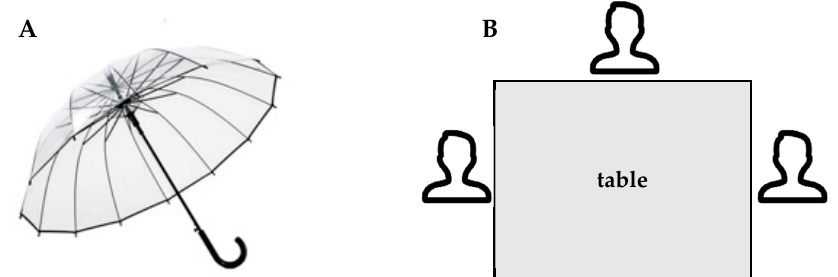
Figure 1. Umbrella prototype and seating arrangement. ( A ) the umbrella prototype, which was presented to the participants during the instruction process, so that the group members had a consistent umbrella prototype, and the prototype picture was retrieved before the formal discussion. ( B ) The seating arrangement, in which the three members freely chose seats according to the seating arrangement and two cameras were used to record the discussion.